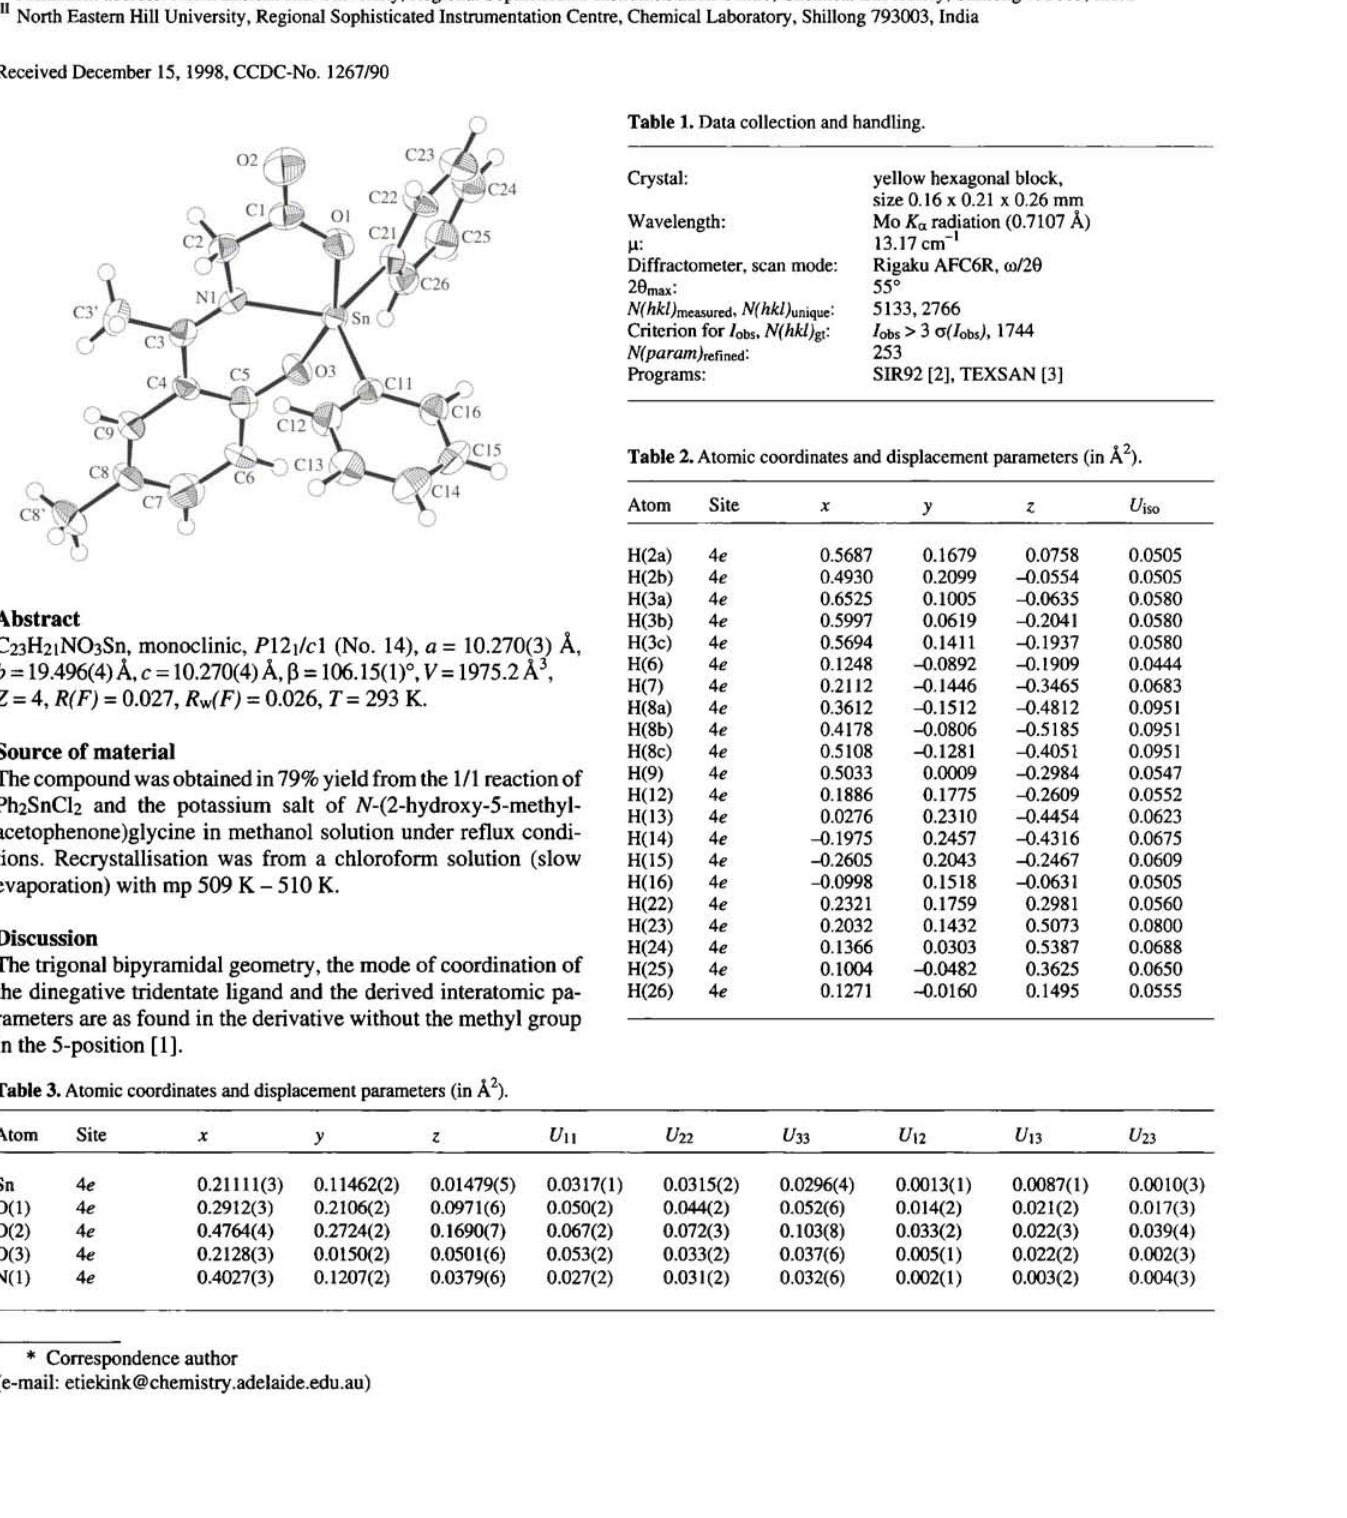
Table 1. Data collection and handling.